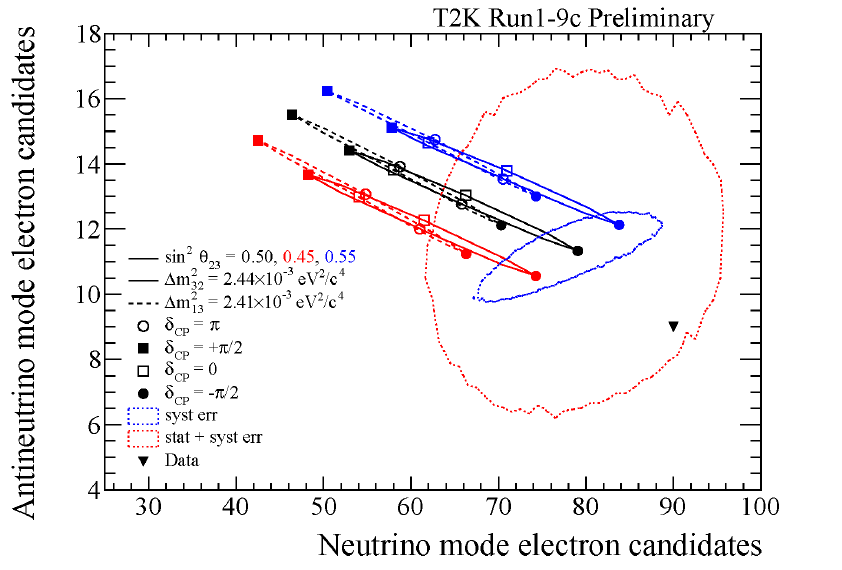
Figure 6. The three pairs of narrow ellipses show the expected numbers of anti electron–neutrino events and electron–neutrino events for optimized systematic parameter values. The solid (dashed) ellipses are for normal (inverted) mass ordering. The value of δ CP locates the prediction on any of the ellipses. The observed number of events is shown by the inverted triangle. The region with the blue jagged border centred around the expectation for (sin 2 θ 23 = 0.5, δ CP = − π /2, normal ordering) shows the region containing 68% of the predictions (for that choice of physics parameters) when systematic parameters are treated as random variables constrained by T2K and external data. The larger region with the red jagged border represents 68% of experimental outcomes distributed according to Poisson random variables whose expectation values are distributed due to the systematic